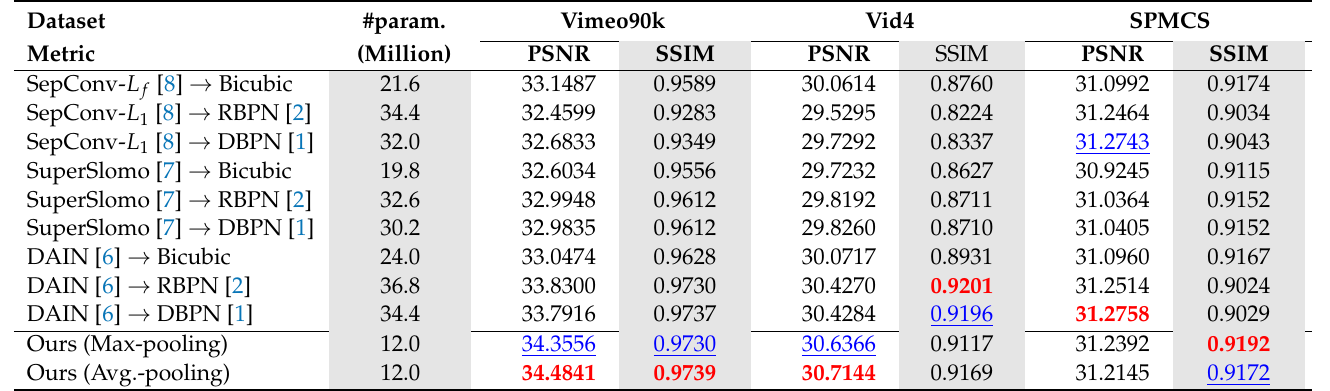
Table 2. Spatio-temporal SR performance on the Vimeo90k, Vid4, and SPMCS datasets against combinations of the state-of-the-art interpolation and SR methods. The best performing and runner- up methods are marked in red and blue,